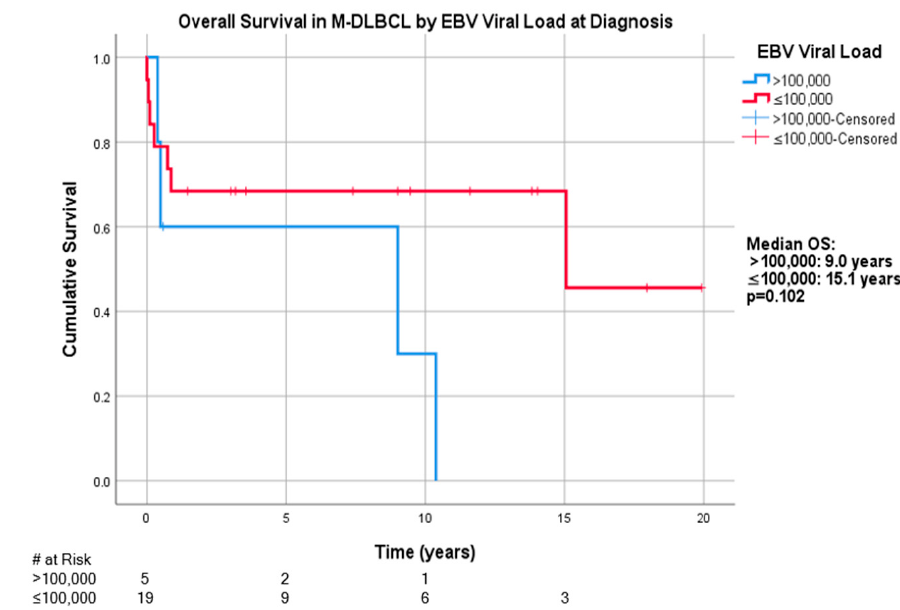
Figure 4. ( A ) Overall survival in the M-DLBCL-PTLD cohort with reported EBV quantification at the 10,000 copies/mL cutoff. ( B ) Overall survival in the M-DLBCL-PTLD cohort with reported EBV quantification at the 100,000 copies/mL cutoff.